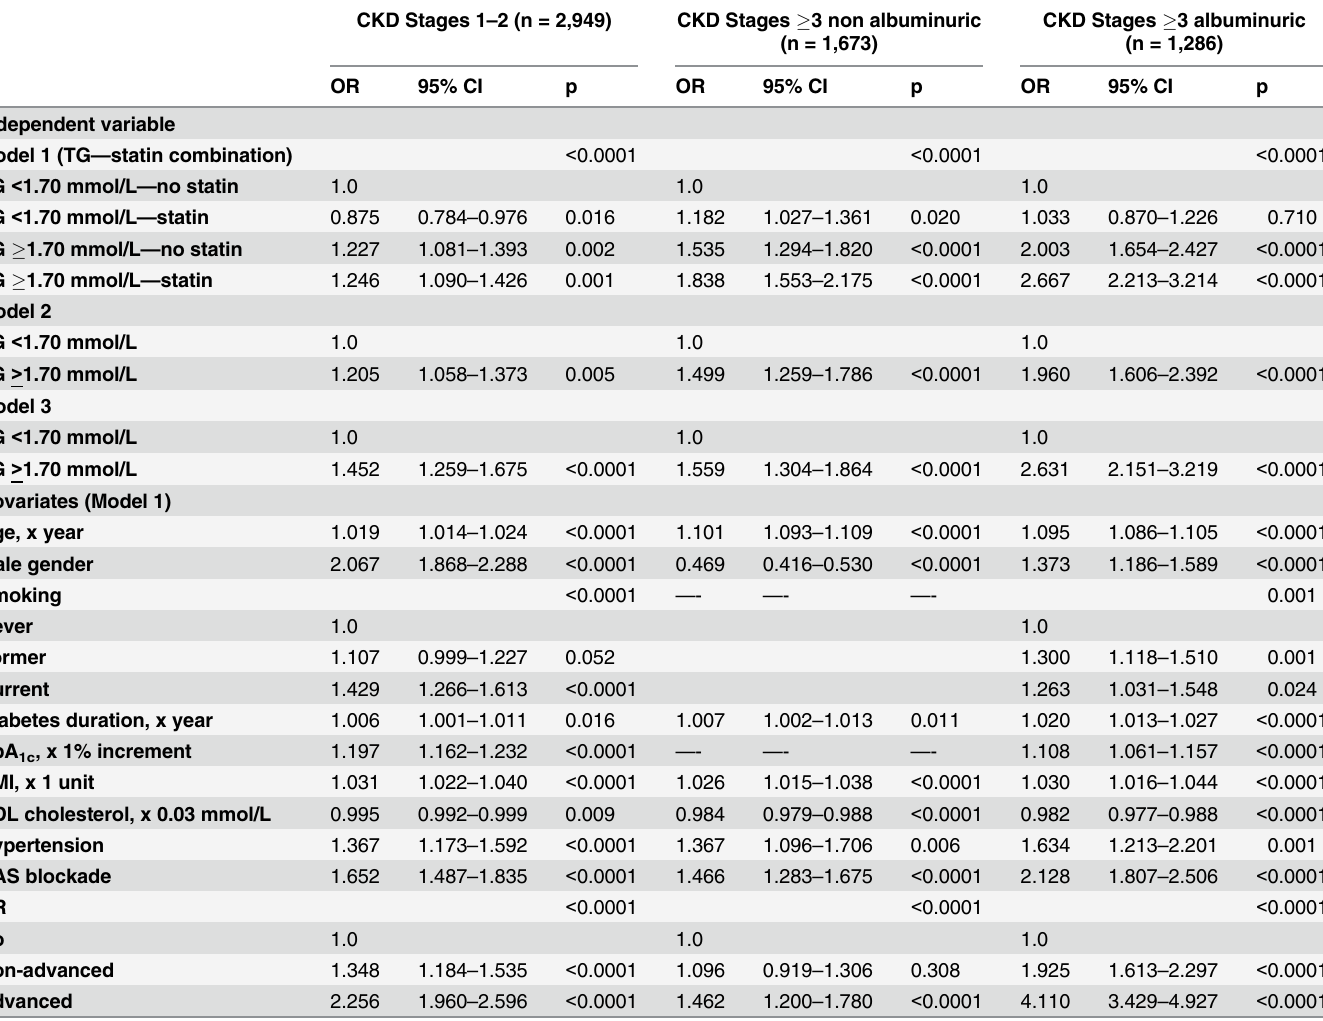
Table 3. Role of triglyceride levels & statin treatment as covariates of CKD phenotypes in the RIACE study.